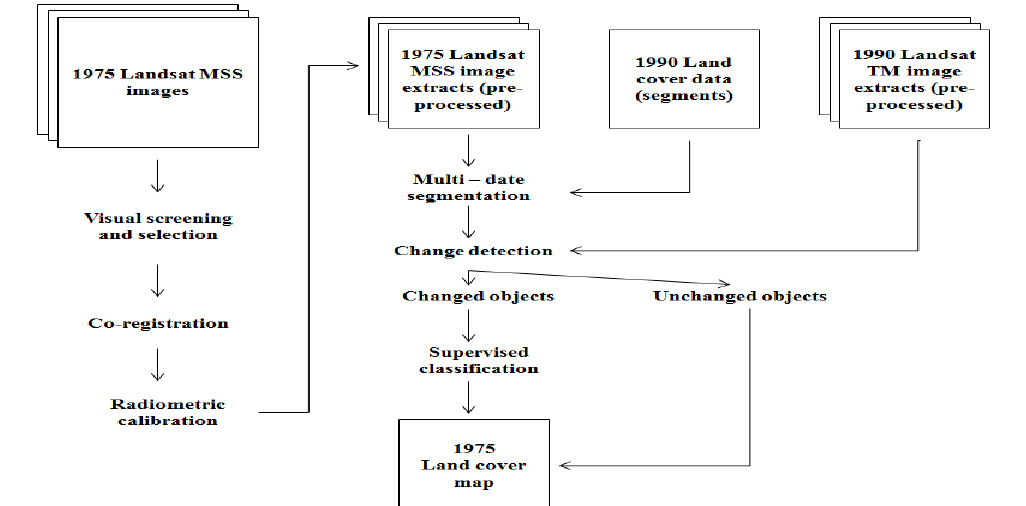
Figure 6. Scheme of TREES data processing chain with adaptation for Landsat MSS